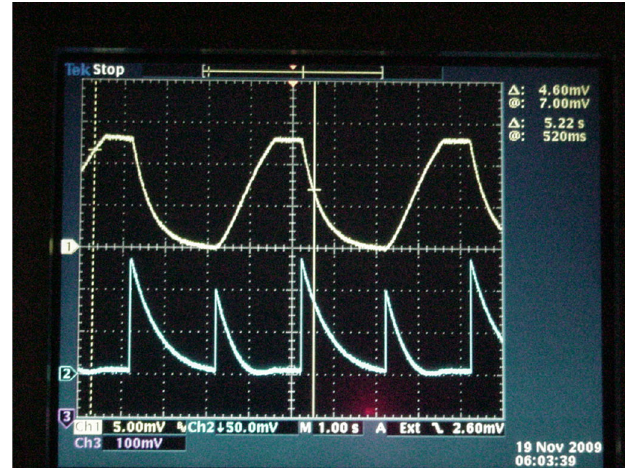
FIG. 6. (Color) Multipacting barrier encountered in the coaxial line: upper trace, transmitted signal; lower trace, reflected signal.